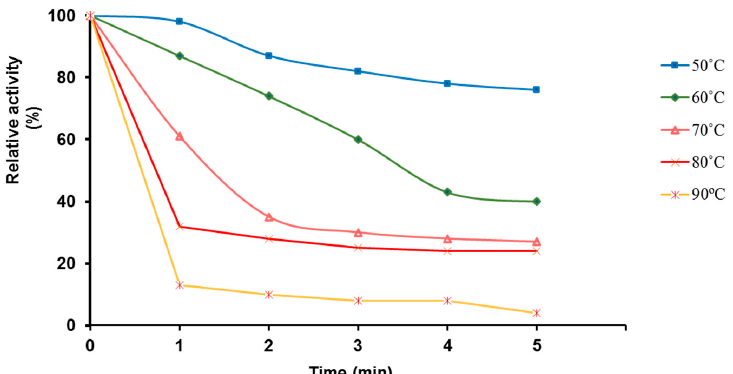
Figure 6. Thermostability of the sialidase from O. paurometabola O129. Each measurement point reflects the number of minutes during which the enzyme was subjected to the action of the corre- sponding temperature, after which it was cooled, and its activity was tested. Results are presented as percent residual activity relative to the activity of an unheated control enzyme sample.